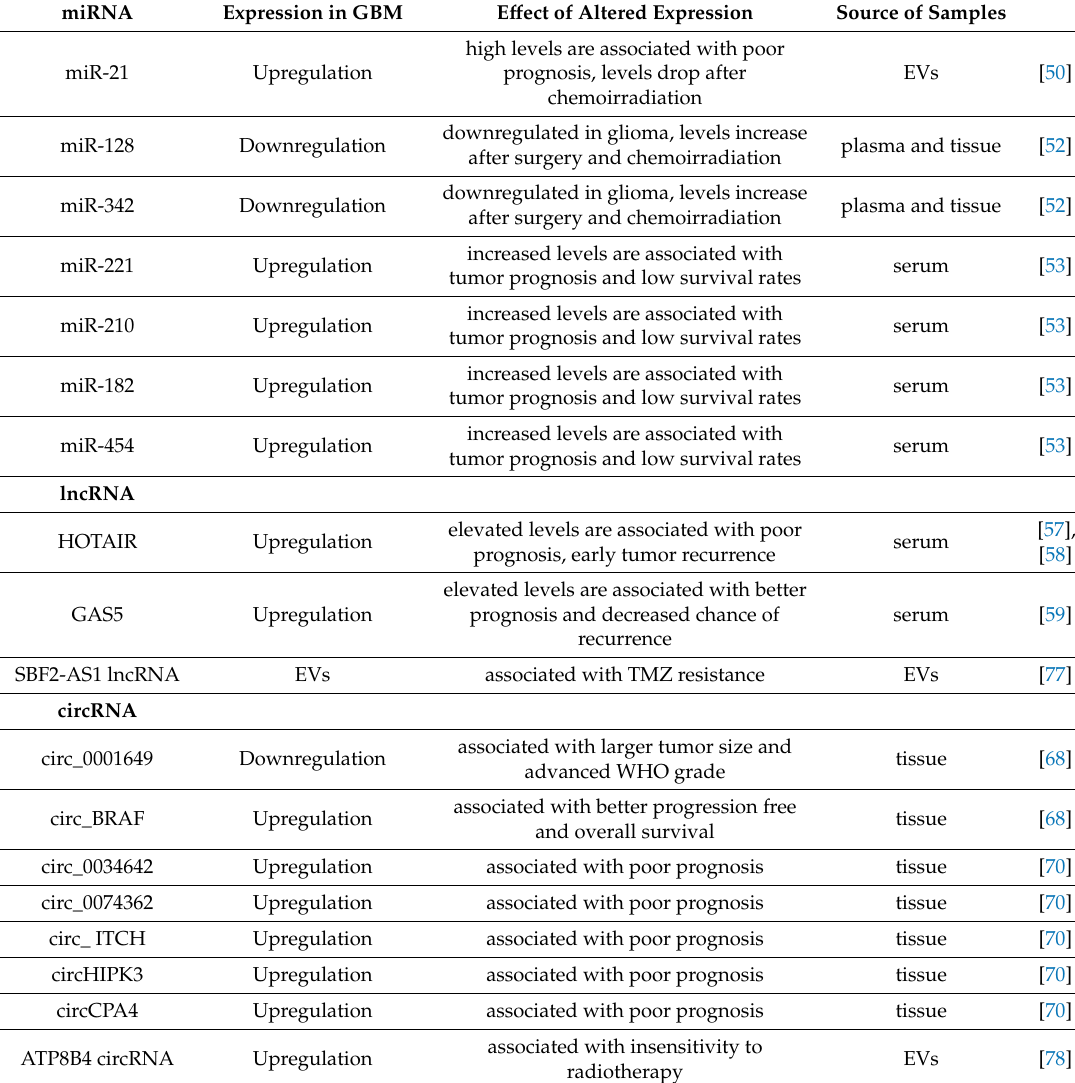
Table 1. Various miRNAs, lncRNAs, circRNAs as diagnostic / prognostic biomarkers in glioblastoma (GBM).